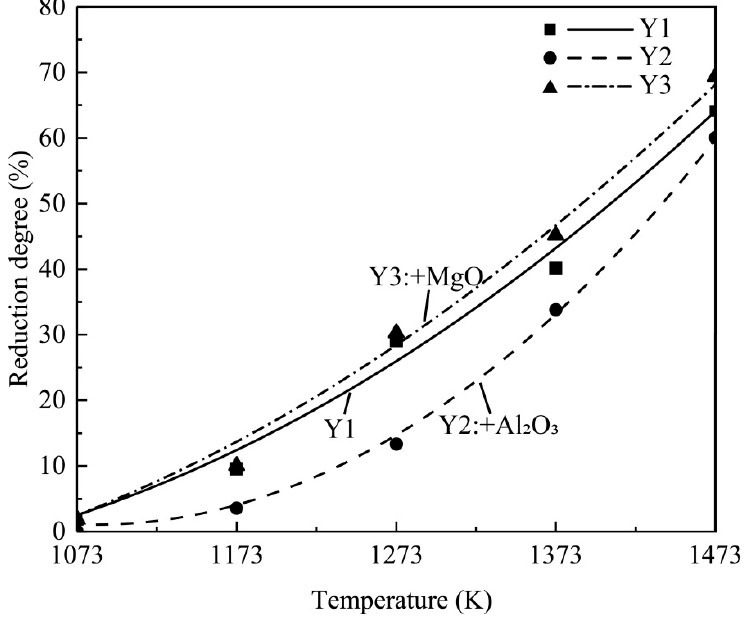
Figure 7. Comparison of reduction degree of three slags after 3500 s reaction; the symbols are experimental results and the lines are data fitting.